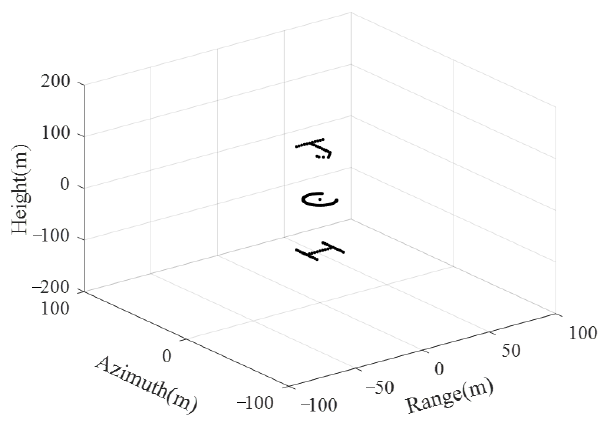
Figure 8. Geometry of the simulated targets.